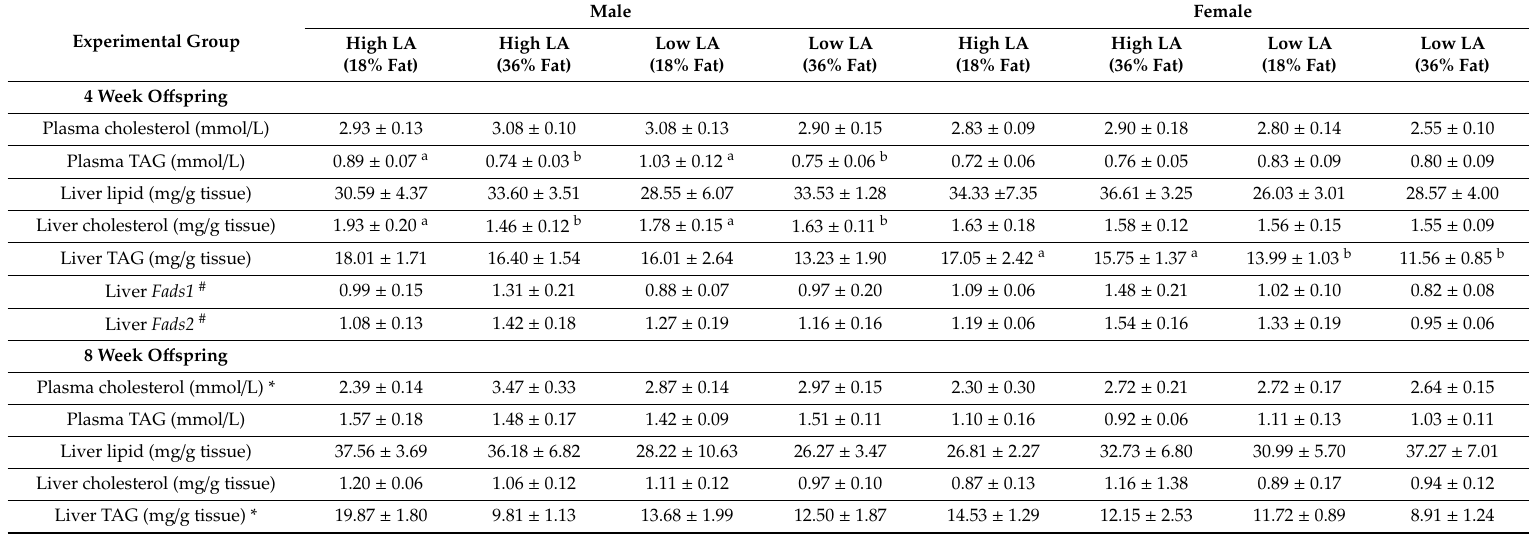
Table 2. O ff spring lipid and liver characteristics at 4 and 8 weeks of